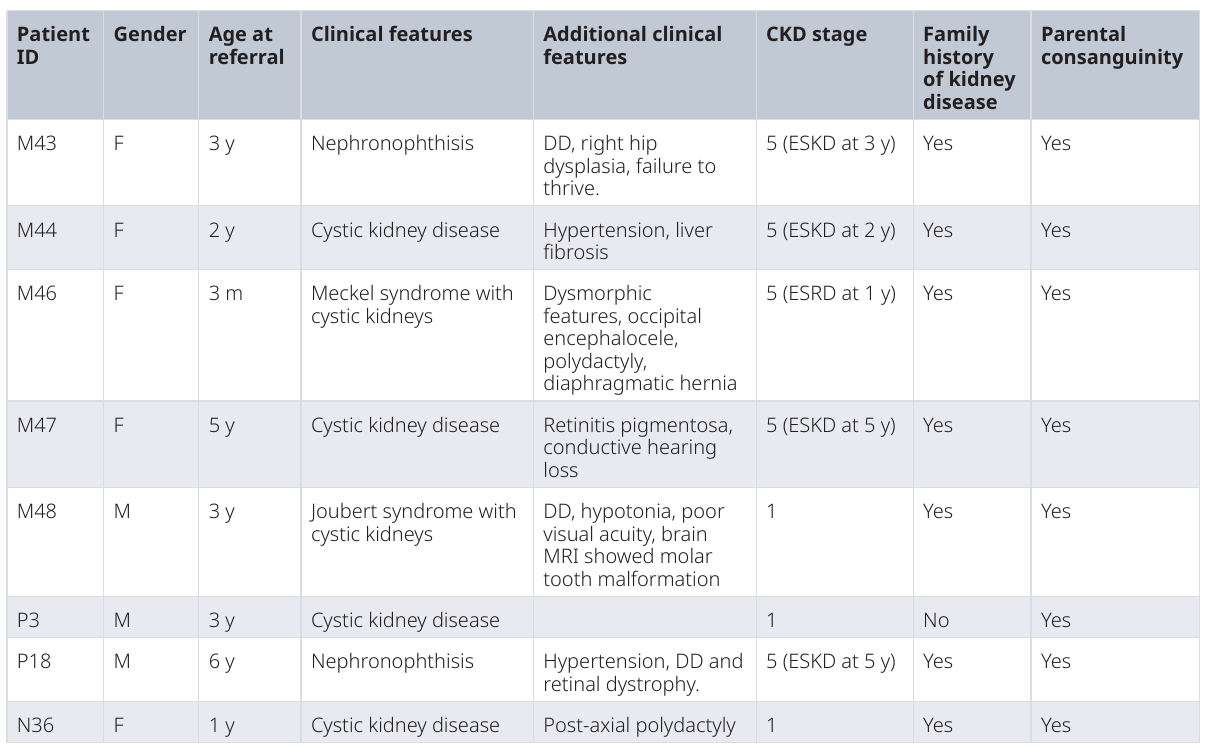
Table 1. Clinical characteristics of Omani